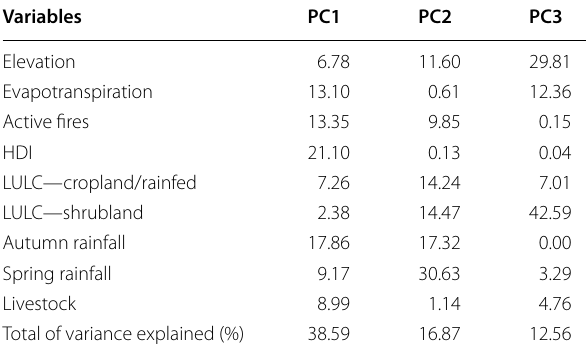
Table 3 Contribution percentage (in %) of the variables analyzed for PC1, PC2, and PC3, with their respective to total variance explained (in